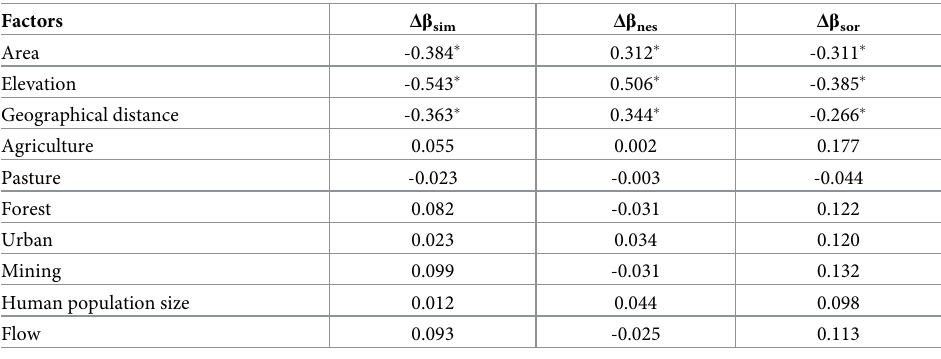
Table 2. Correlations between differentials of turnover ( Δβ sim,Current = β sim,Current – β sim,Historical ), nestedness (